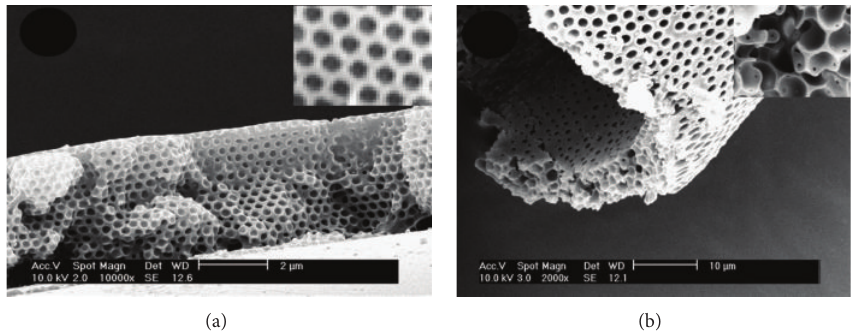
Figure 13: Cross-section of polyurethane fiber with glass core (a) and with hollow core (b), respectively,